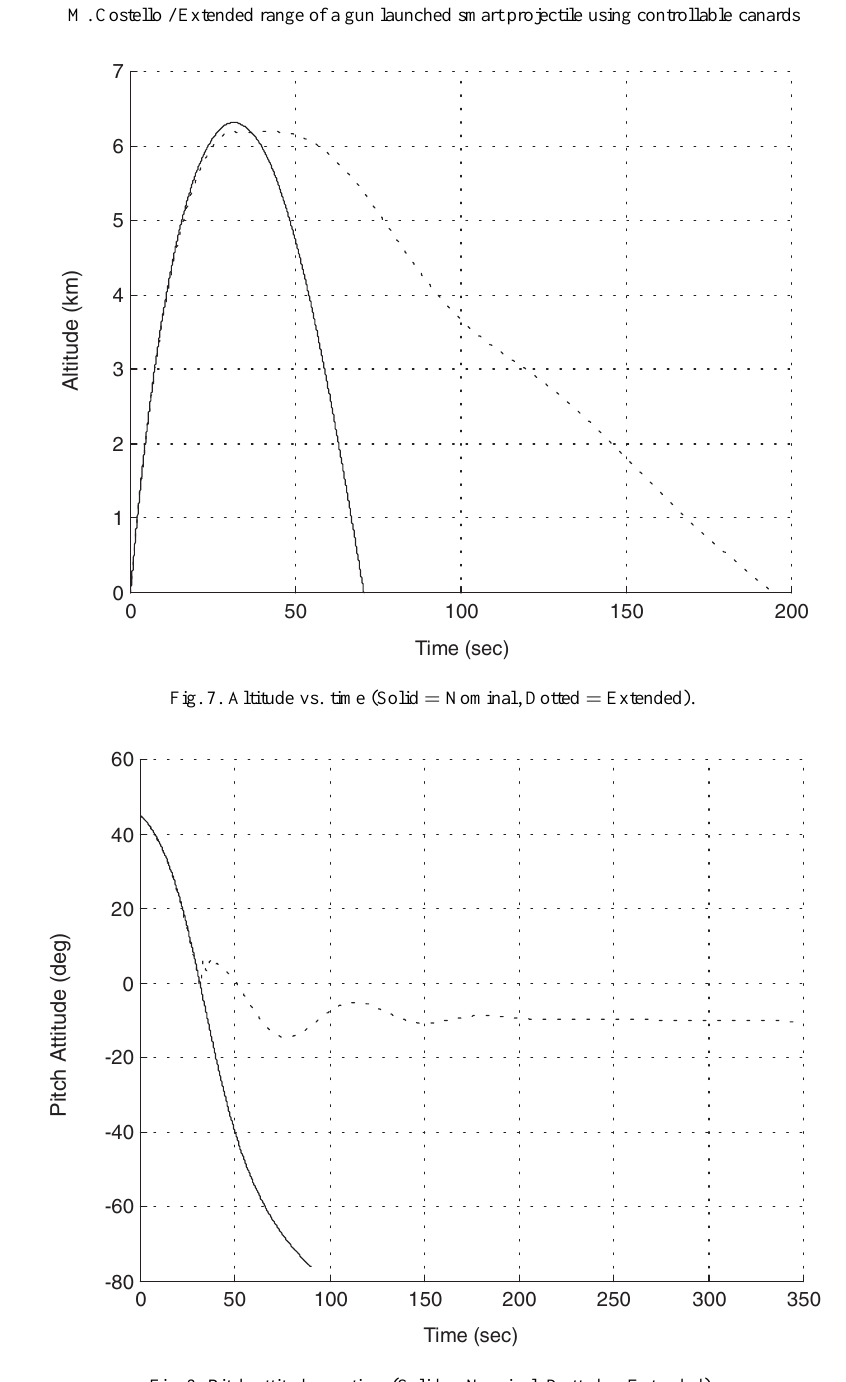
Fig. 8. Pitch attitude vs. time (Solid = Nominal, Dotted =